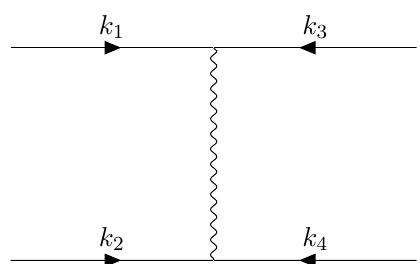
Figure 1 . Feynman diagram representation for tree-level scalar scattering with graviton exchange. The solid lines represent scalar states and the wavy lines represent